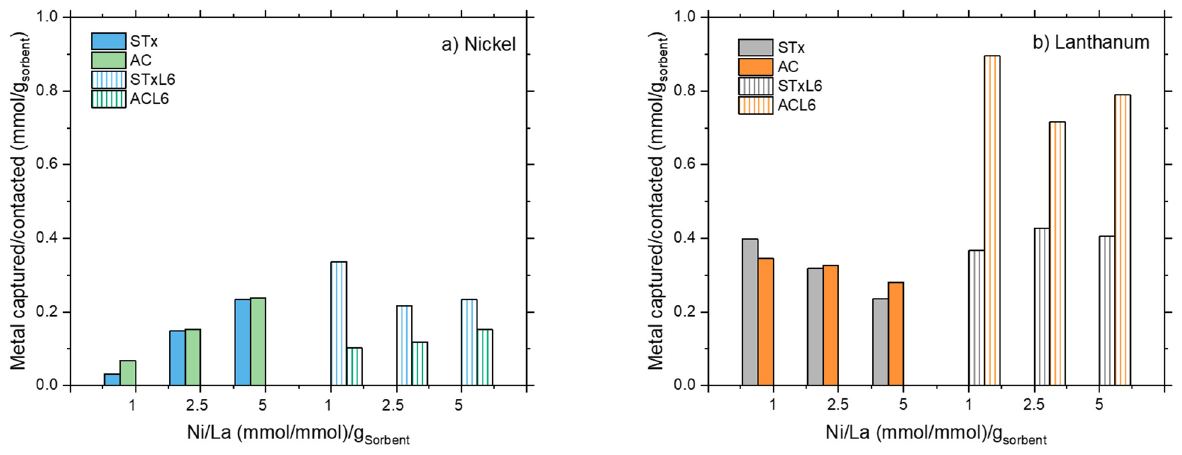
Figure 9. Comparison of the capture capability of the different sorbents towards.